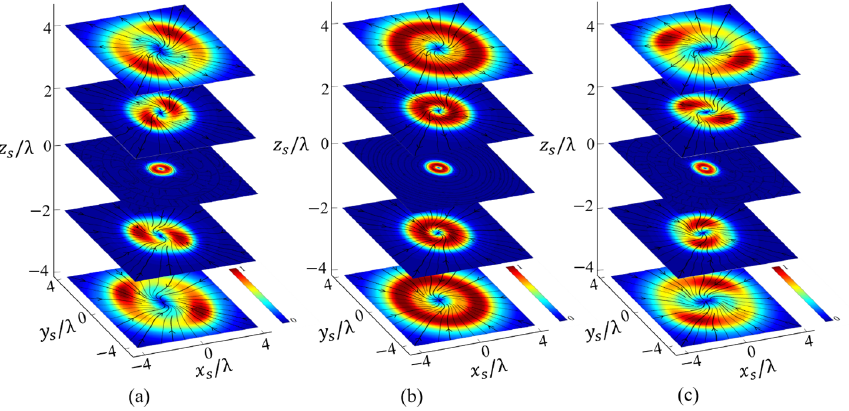
( a ) σ c = 0.5; ( b ) σ c = 1; Figure 7. The transverse energy flow p Figure 7. The transverse energy flow 𝐩 (cid:3051)(cid:3052) along the propagation direction: (𝐚)𝜎 (cid:3030) = 0.5; (𝐛)𝜎 (cid:3030) = xy along the propagation direction: ( c ) σ c = 2. In all the plots l = 1; (𝐜) 𝜎 (cid:3030) = 2.In all the plots 𝑙 = 1 .